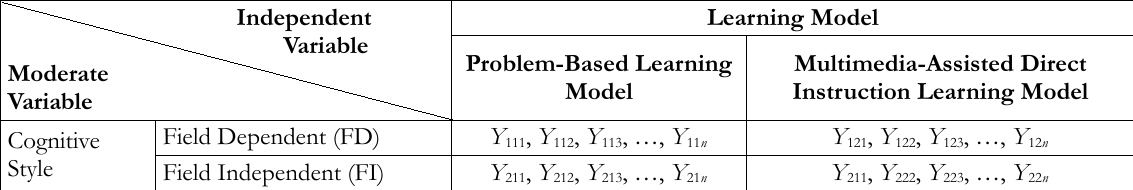
Table 1. Research design (2x2)